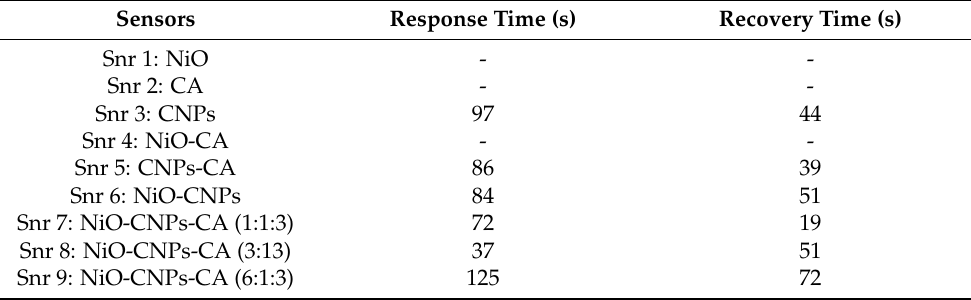
Figure 10. Dynamic response-recovery curve ∆ R response as a function of time at variable concentrations of ( a ) CNPs-CA ( b ) NiO-CNPs. Table 1. Response and recovery time of the sensors during mesitylene